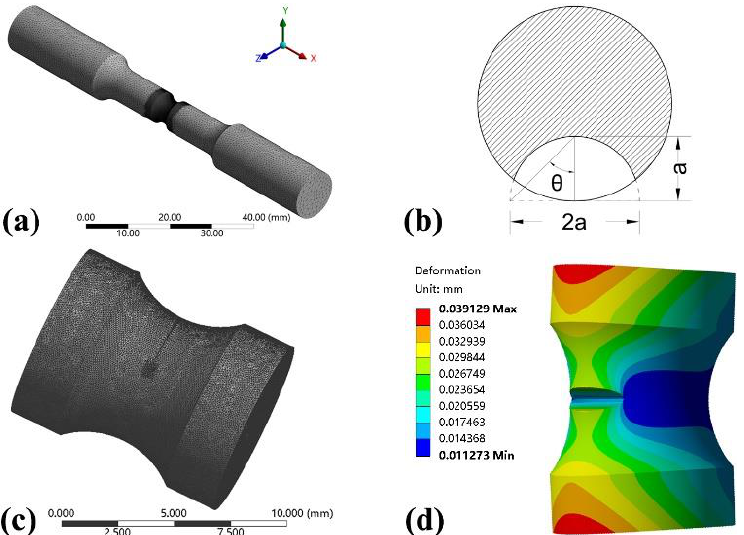
Figure 11. ( a ): Model of the specimen with the a crack in the plane of the smallest section of the specimen; ( b ): Sketch map of the semi-elliptical shape crack in ( a ); ( c ): Enlarged view of the 10 mm part containing the crack a = 2.0 mm in ( a ); ( d ): Deformation distribution of the 10 mm part in ( c ) under a tensile load of 18,539 N along the axis direction of the